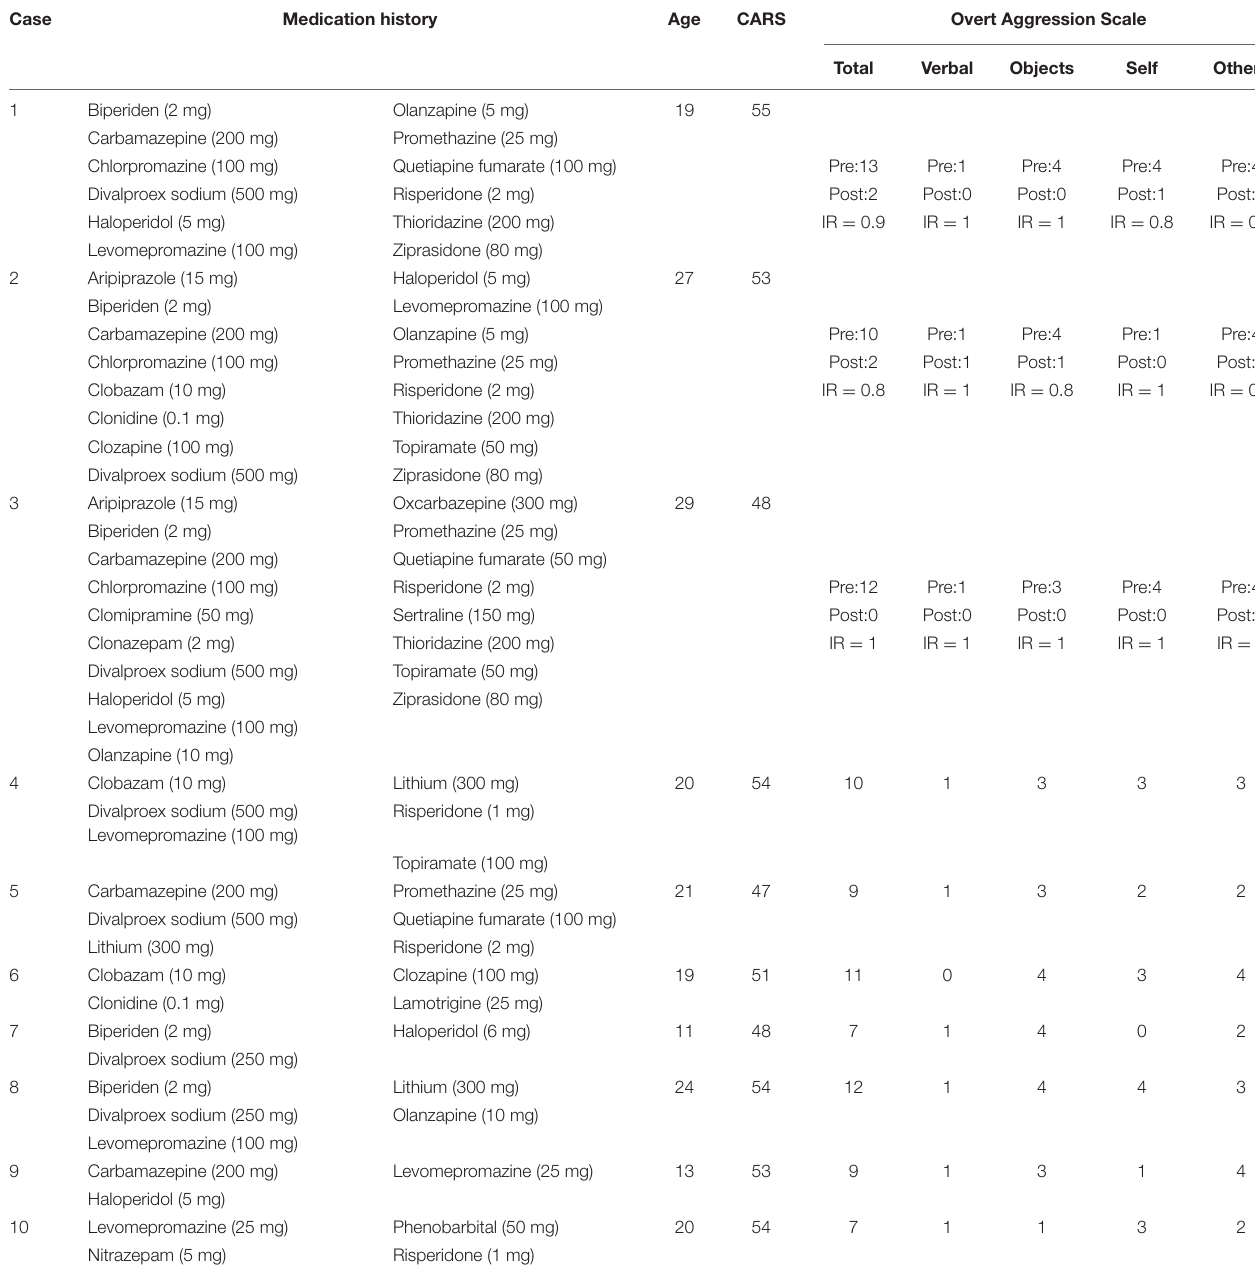
TABLE 1 | Demographics and clinical